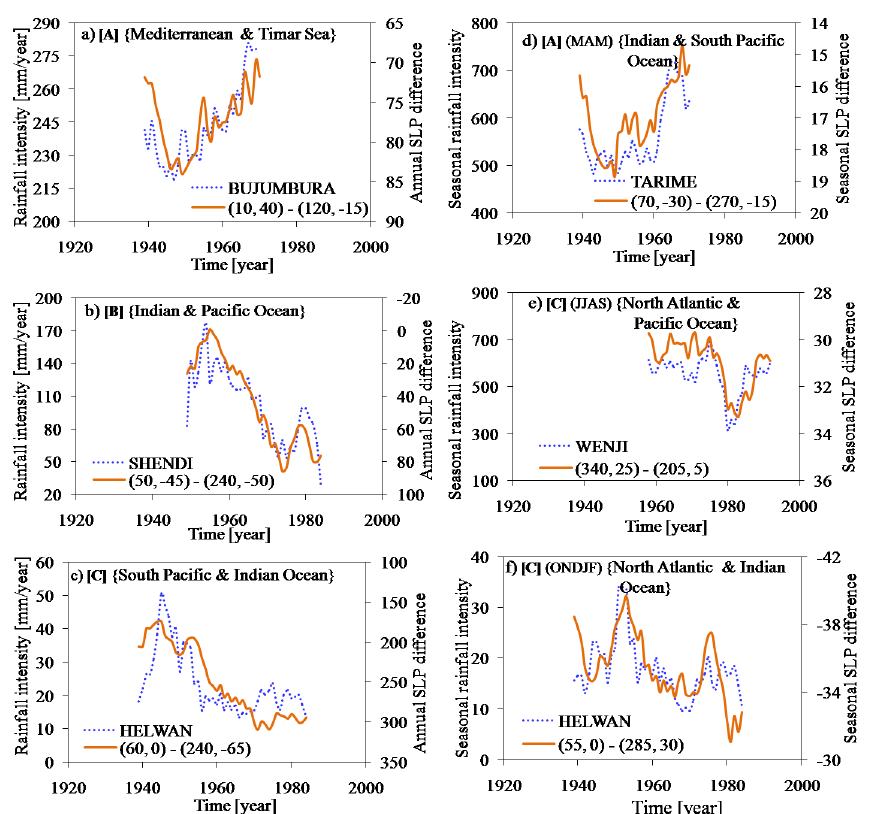
Figure 7. Annual SLP differences and rainfall at selected stations of the different groups A–C for a time slice of 5 years; the group labels are in [ ] . The label of a legend indicates the coordinates (degree longitude and latitude) from where the SLP differences were taken. The label in { } show the locations where the coordinates are found. Annual and seasonal timescales are shown in charts (a)–(c) and (d)–(f) ,